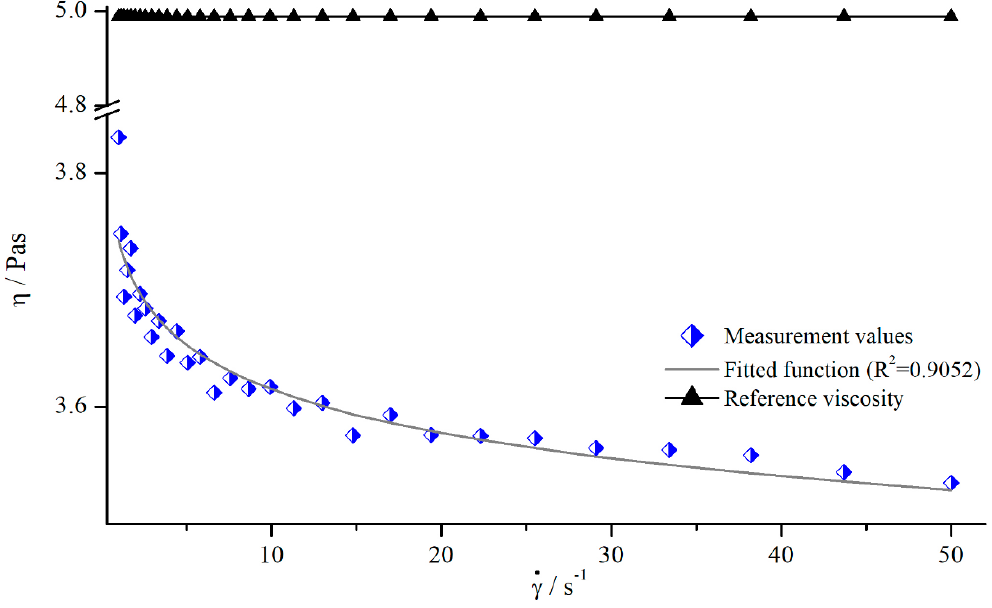
Figure 5. Apparent viscosity of silicon oil AK 5000 as a function of shear rate using bars (system 13) at a gap height of 𝐻 = 1.2 mm and reference viscosity determined with smooth plates.